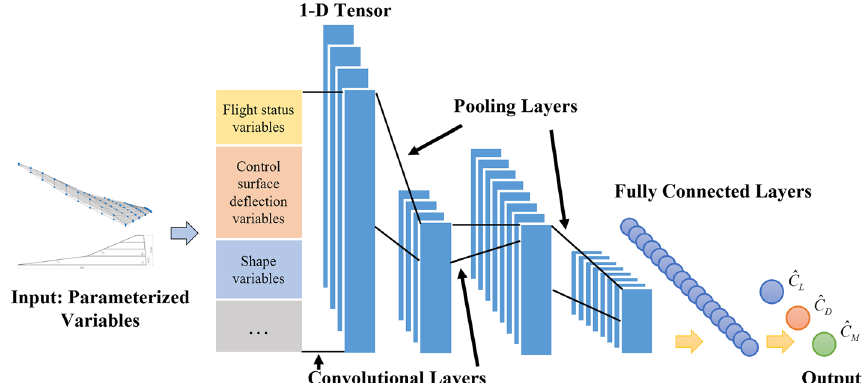
Fig. 3 Modified CNN architecture for aerodynamic data